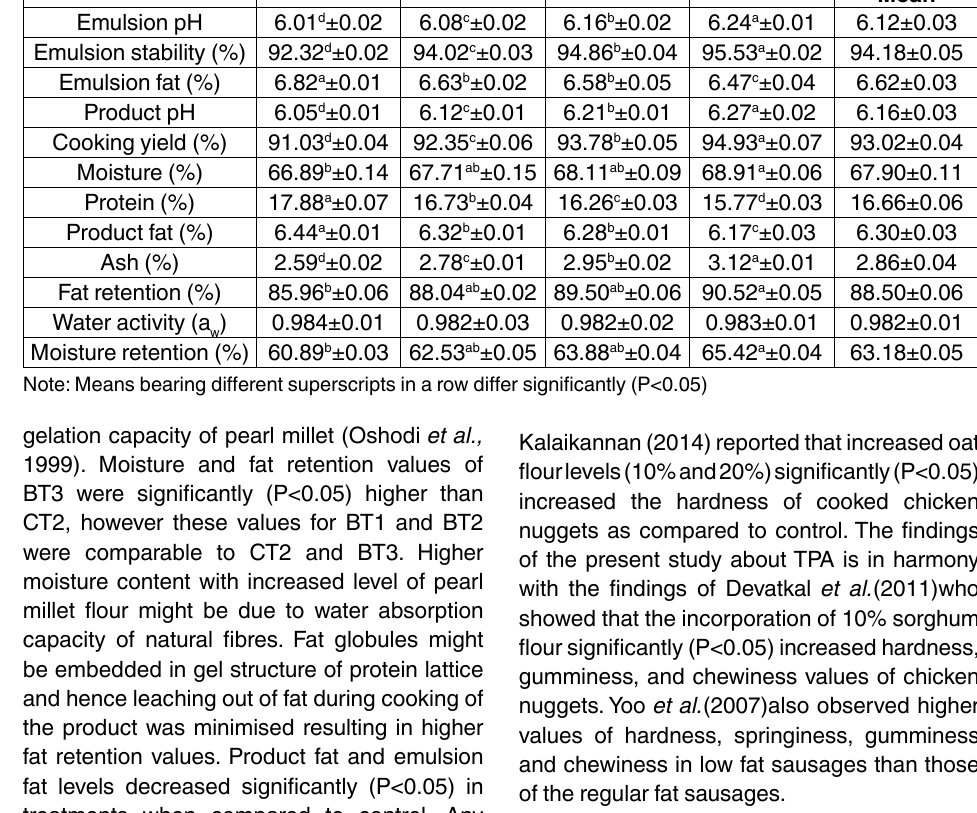
table 2. Effect of pearl millet flour on physico-chemical parameters (Mean±SE) of chicken sausage